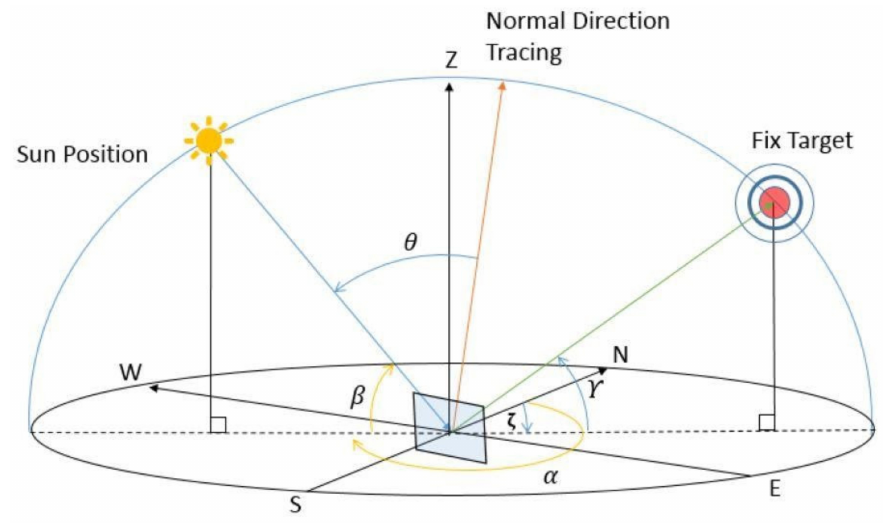
Figure 10. Schematic view of the heliostats, the sun, and the target in the horizon coordinate system.